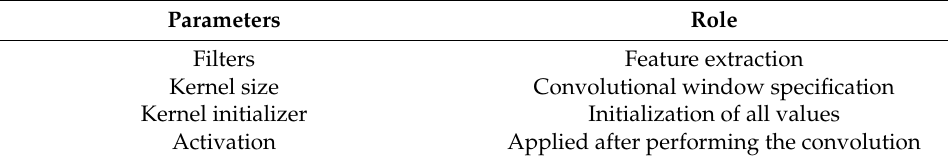
Table 4. Convolutional layers